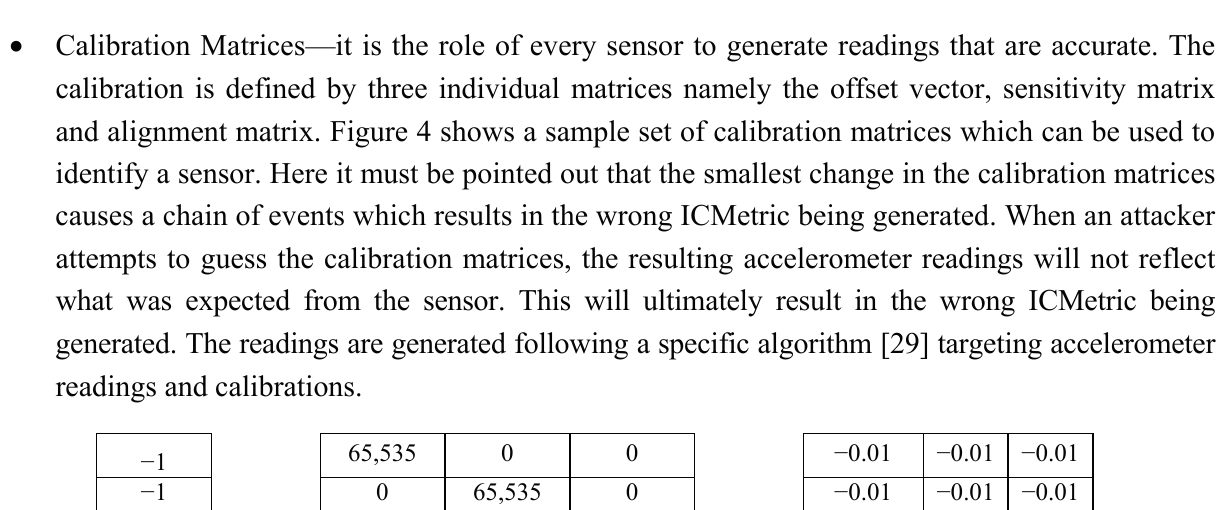
Figure 3. The DS-2411 serialization structure.